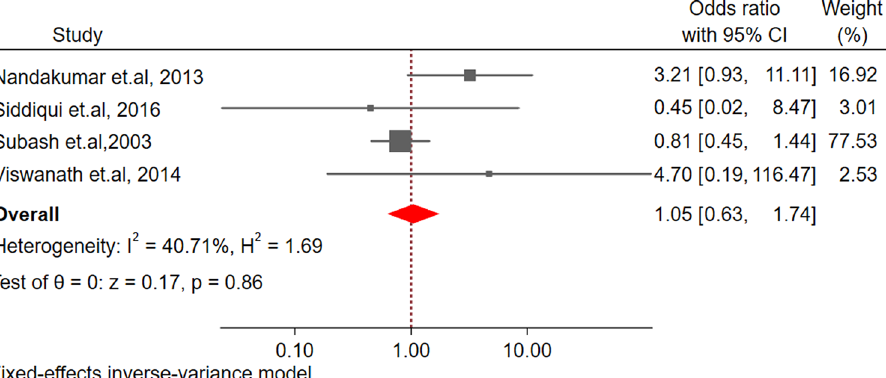
Figure 4. Forest plot for the association between diabetes and multidrug-resistant tuberculosis among tuberculosis patients in South